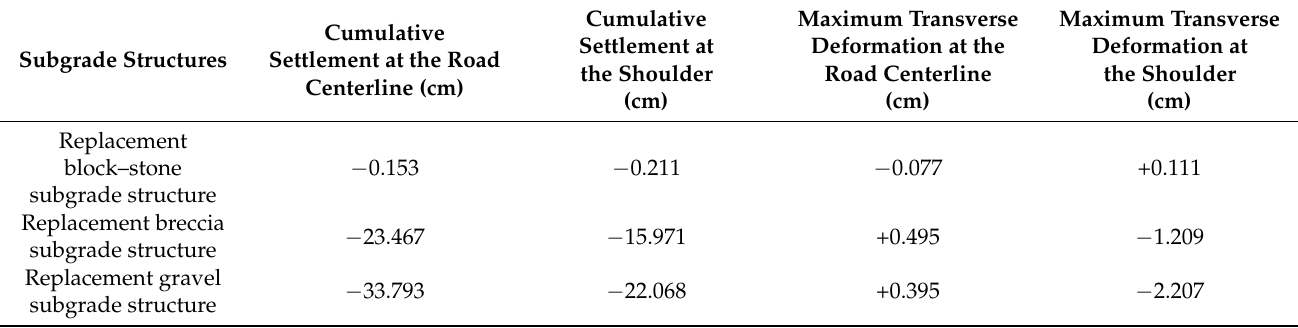
Table 5. Actual maximum deformations of the top surface of the three subgrade structures from 2019 to 2039.